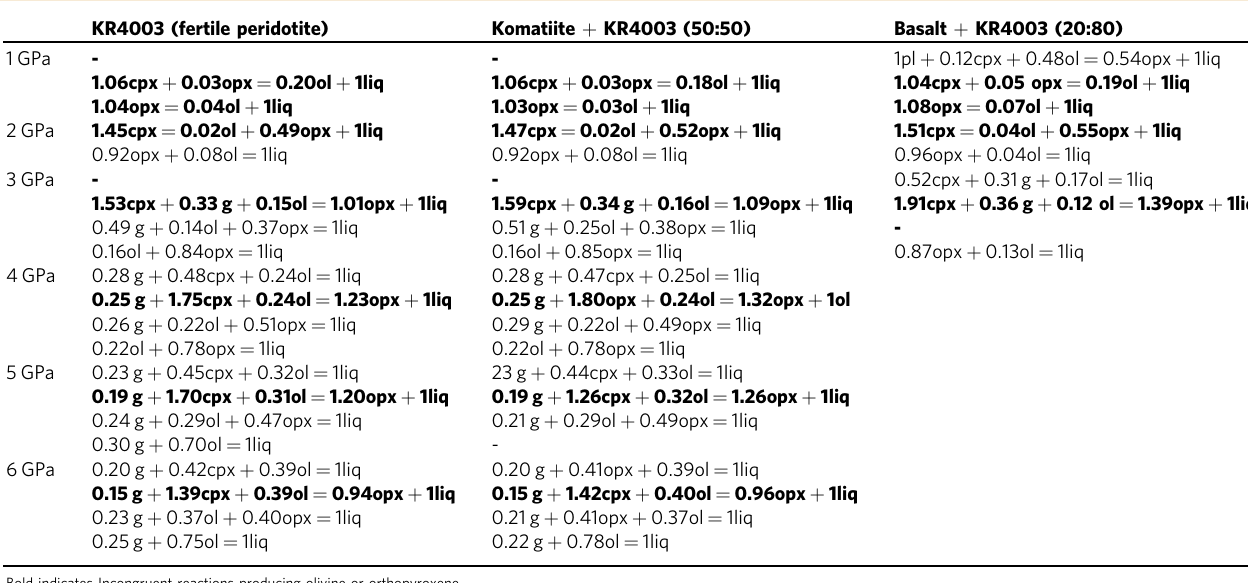
Table 2 Calculated reactions for melting of fertile peridotite and hybrid mantle. Note: reactions were not calculated for fi elds spanning <4%